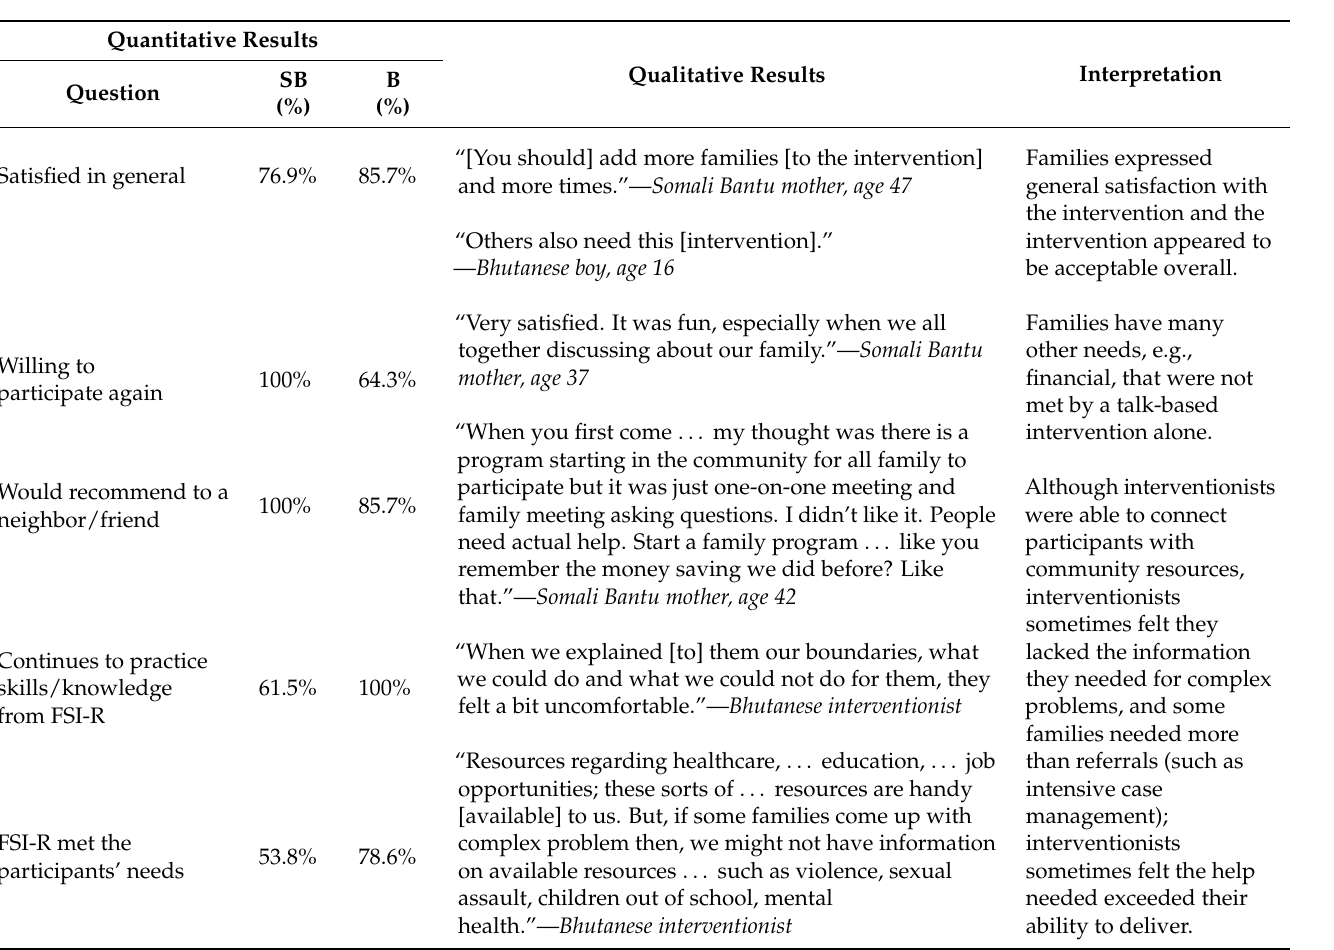
Table 4. Joint display table: Integration of quantitative (percent of caregivers reporting construct) and qualitative (interview data) about acceptability of the